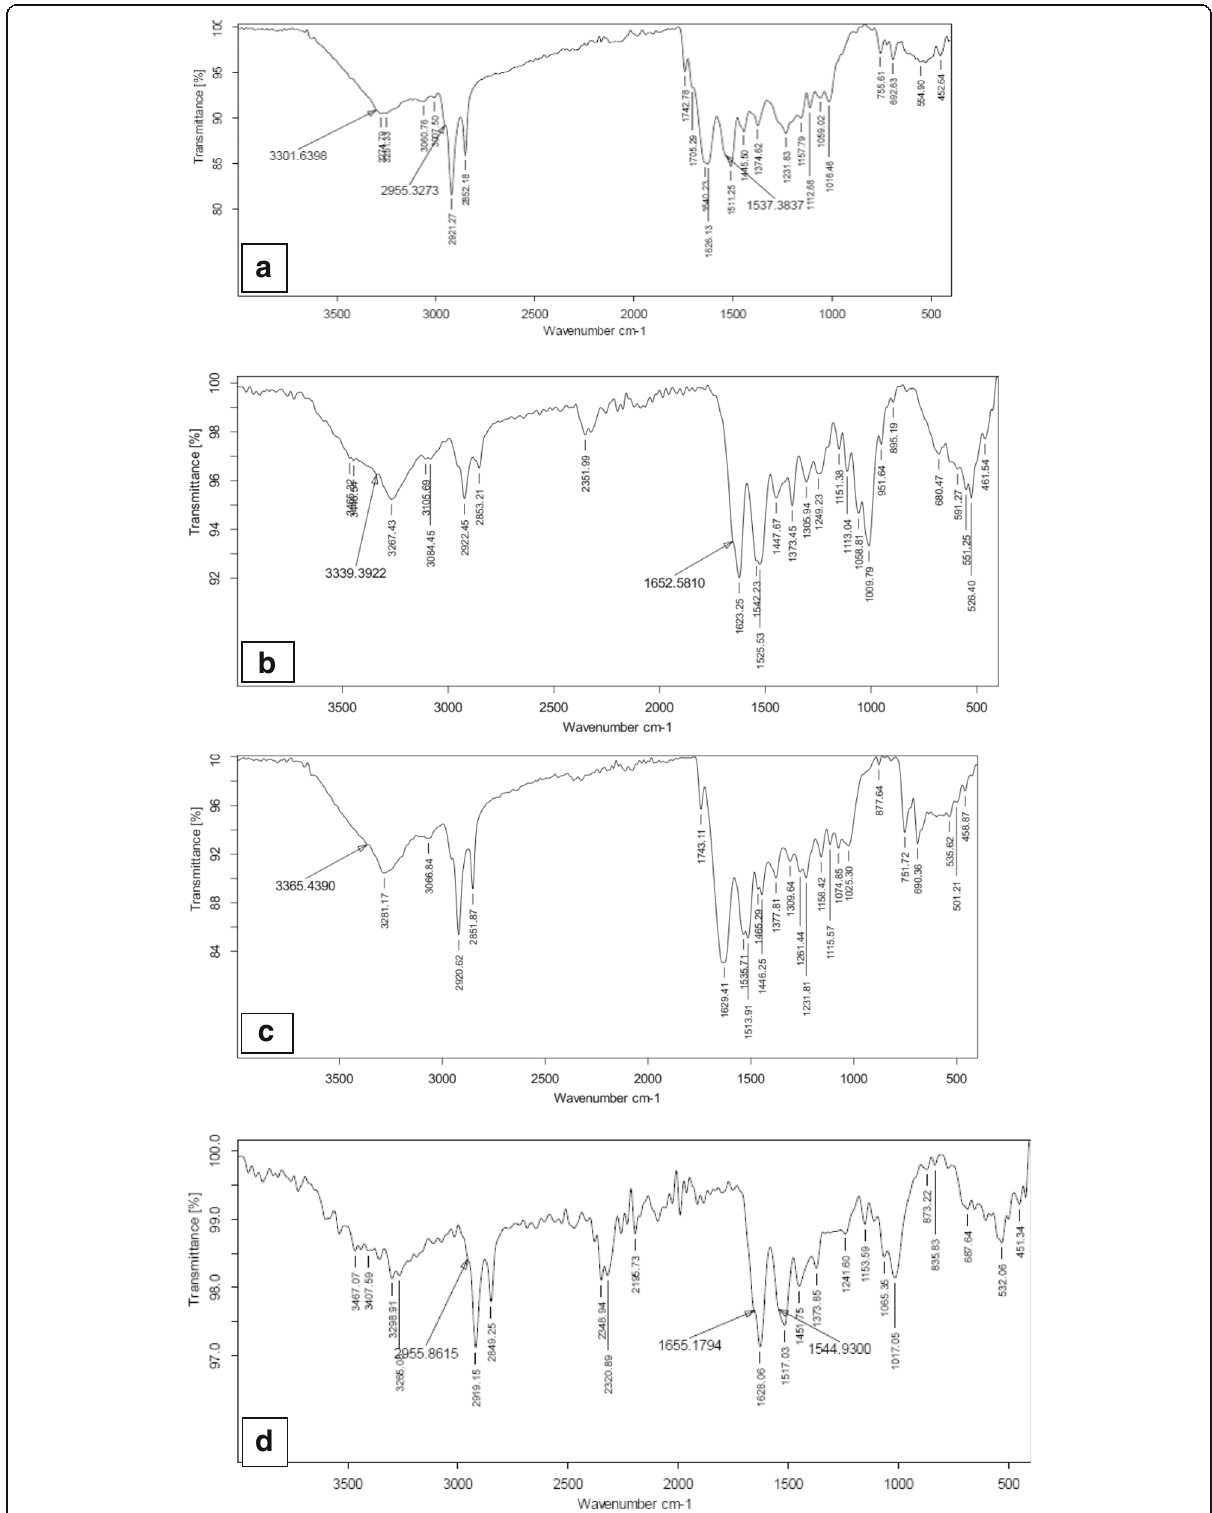
Fig. 8 IR absorbance spectra of the wings of a , c Tribolium castanaeum — a elytron, c hindwing; b , d Tribolium confusum — b elytron, d